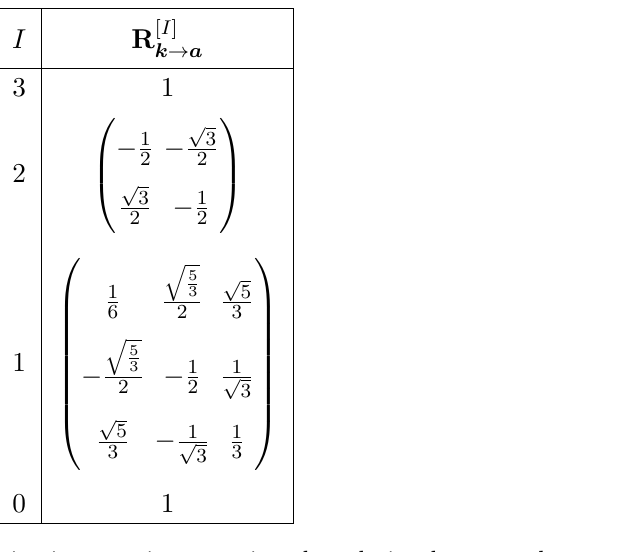
Table 2 . Summary of the symmetrization matrices entering the relation between the scattering amplitude and K [ I ] df ; 3